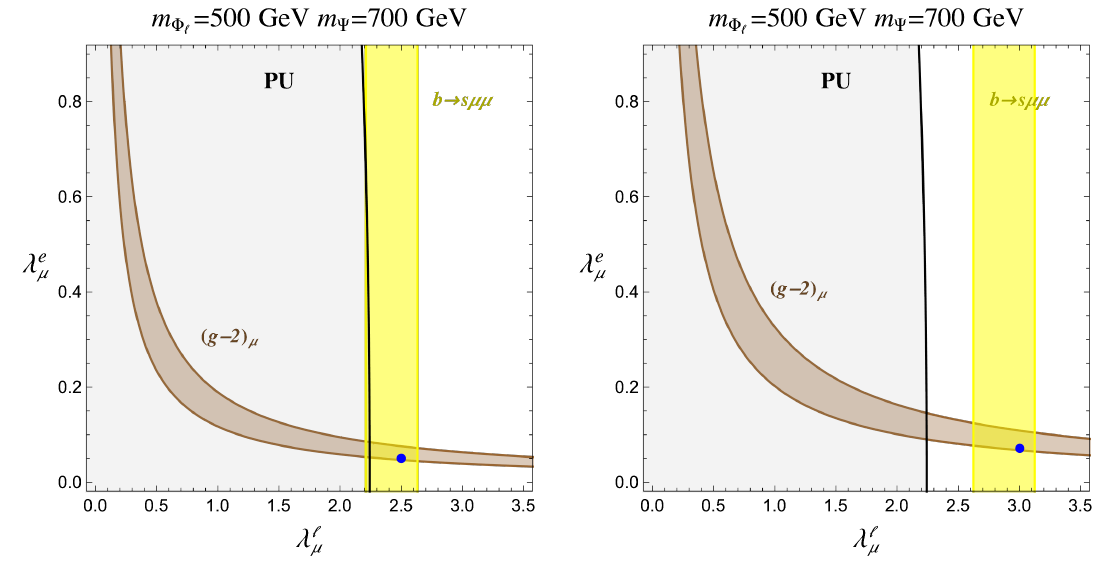
Figure 6 . For benchmark point 1 (left) and benchmark point 2 (right)in gray we show the regions of the parameter space compatible with PU. In brown we show the regions compatible with the anomaly at 2 σ while in yellow the region compatible with ( g − 2) R K ( ∗ ) we show in blue the benchmark points derived from